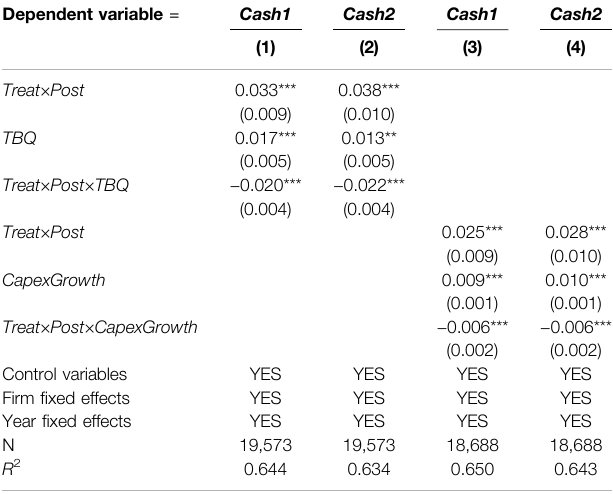
TABLE 10 | The effect of fi rms ’ investment and growth opportunities. Dependent variable